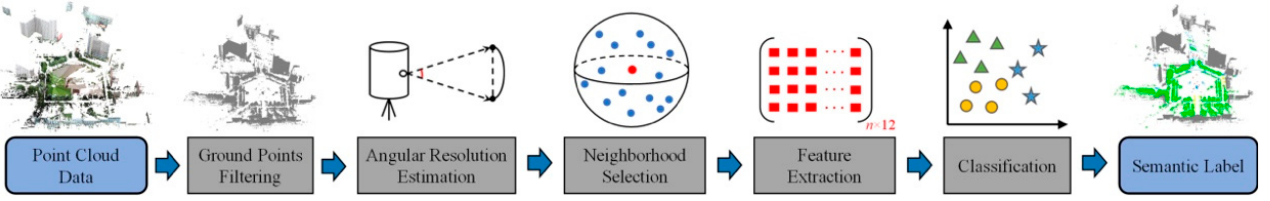
Figure 1. Workflow of our method.